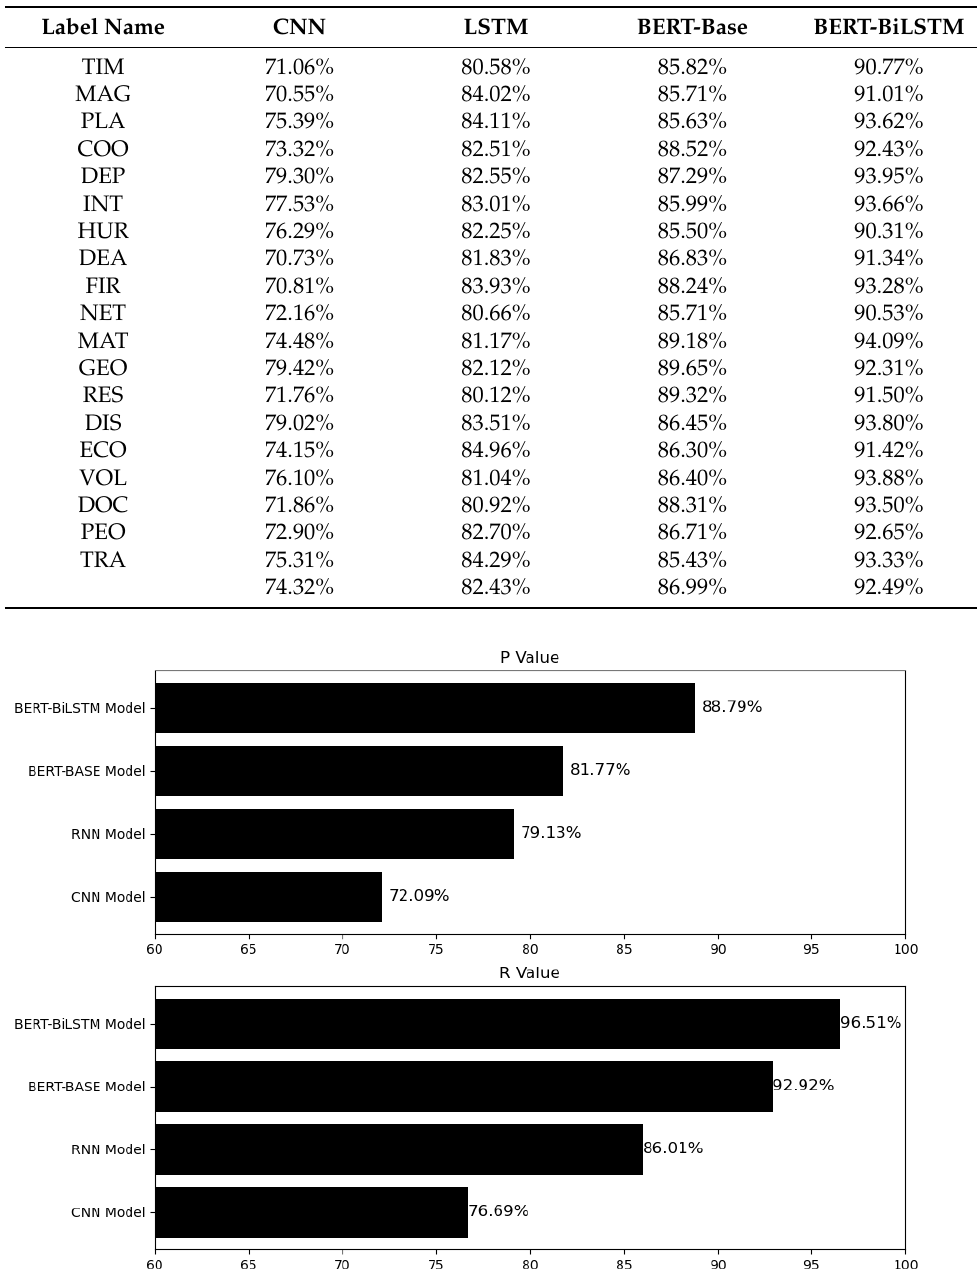
Table 5. Experimental results.